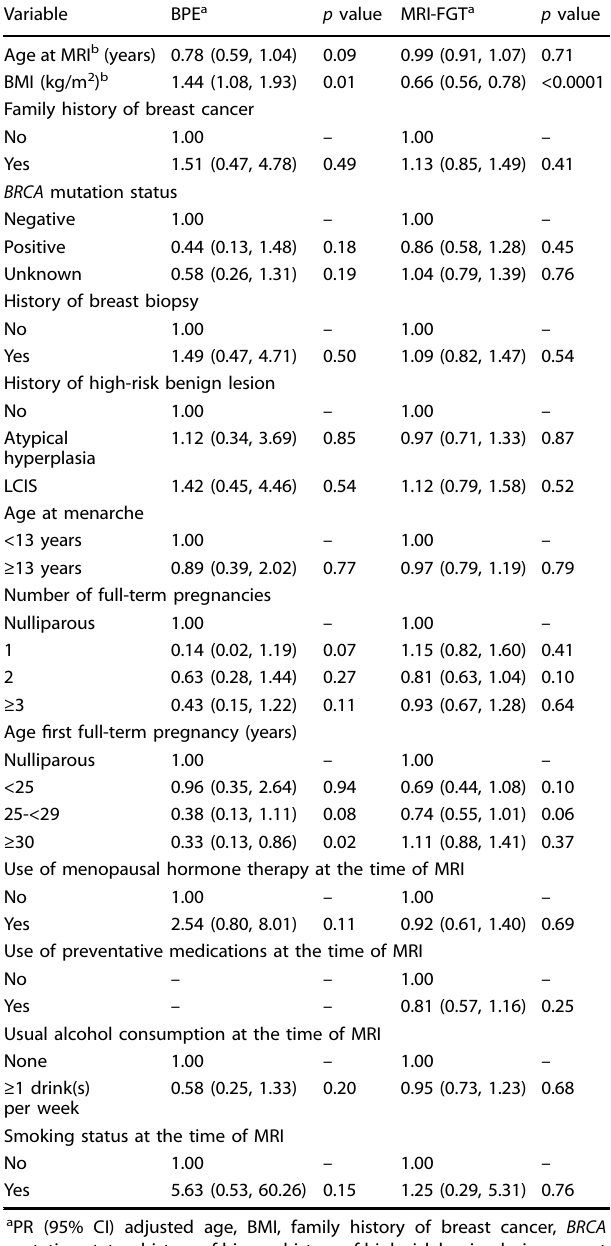
Table 5. Multivariable adjusted prevalence ratios and 95% con fi dence intervals (CI) the relationship between breast cancer risk factors and BPE and MRI-FGT in postmenopausal women.